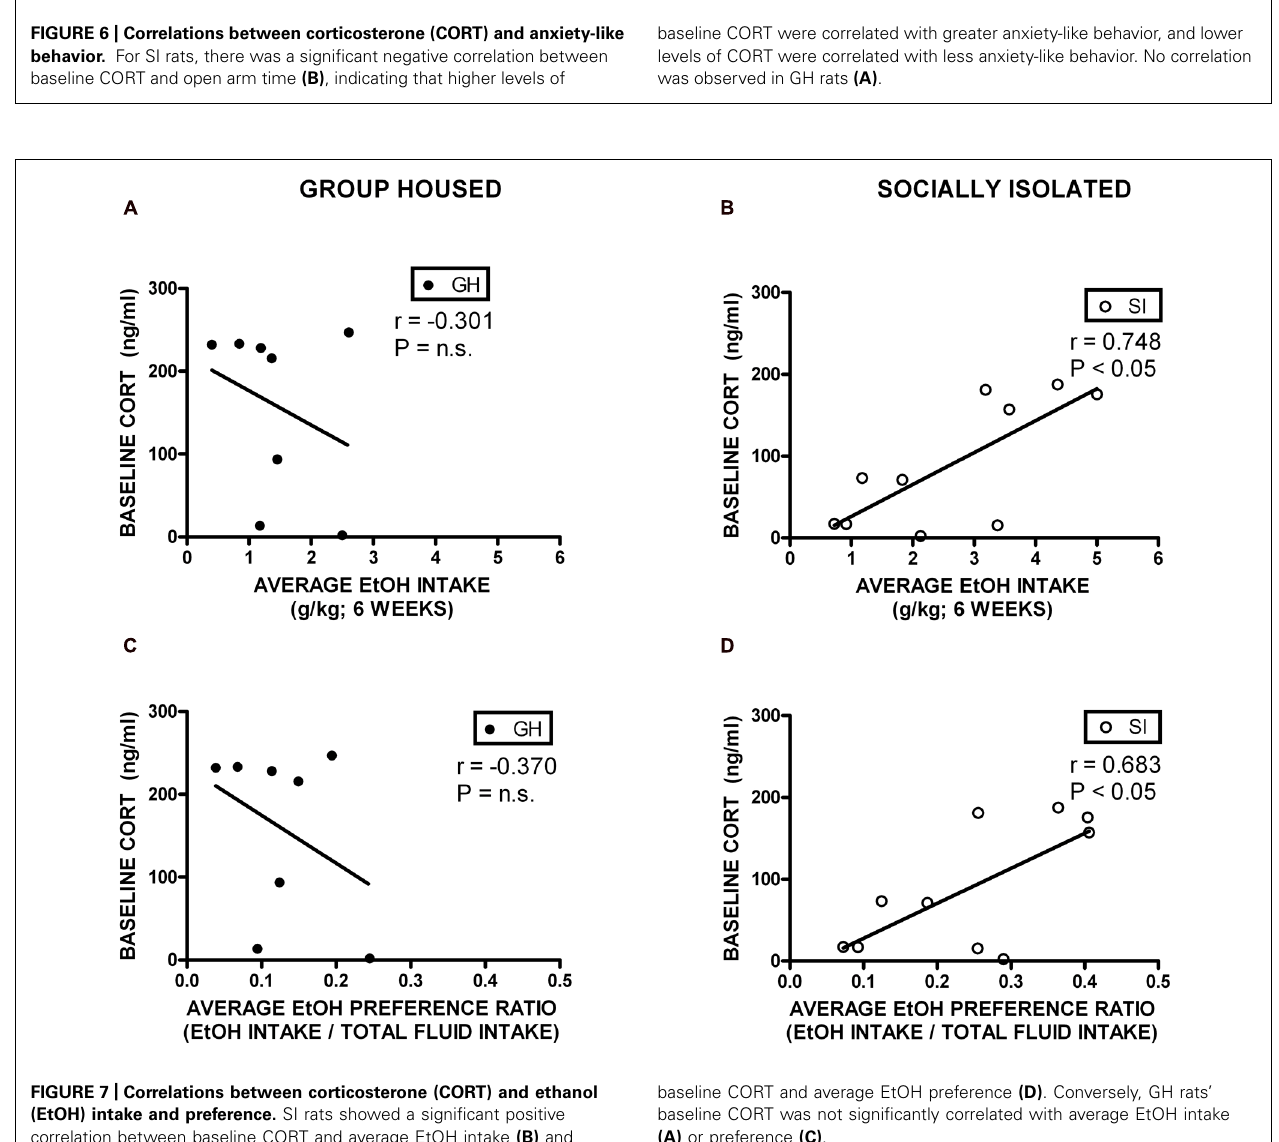
FIGURE 7 | Correlations between corticosterone (CORT) and ethanol (EtOH) intake and preference. SI rats showed a significant positive correlation between baseline CORT and average EtOH intake (B) and